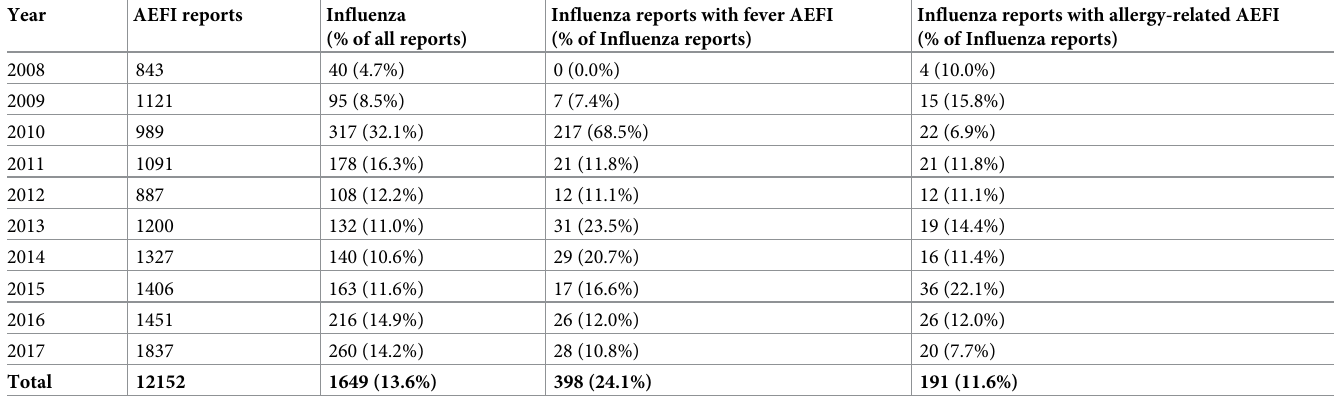
Table 2. Summary of influenza vaccine AEFI reports received by SAEFVIC, Victoria 2008–2017.